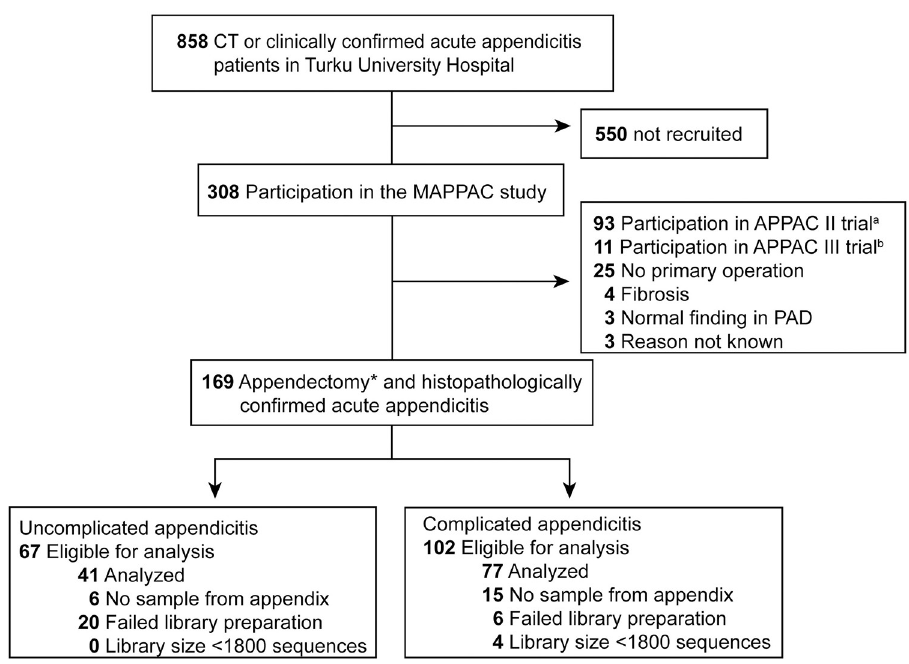
Fig 1. Flow chart of the study. � Appendectomy for primary acute appendicitis. Only patients treated with appendectomy and histopathologically confirmed acute appendicitis study were included in the analysis to have the microbiological sample and to have confirmation for the differential diagnosis. a) Randomized, multicenter, open- label, noninferiority clinical trial comparing oral moxifloxacin with intravenous ertapenem followed by oral levofloxacin and metronidazole. b) Randomized, multicentre, placebo-controlled, double-blind trial comparing antibiotic therapy with placebo in the treatment of uncomplicated acute appendicitis.